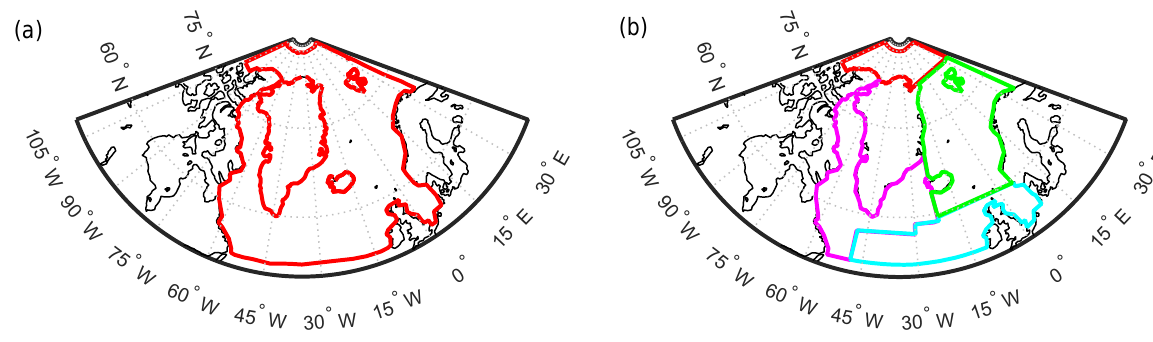
Figure A1. Parameterization of the ocean area around Greenland with one (a) and four (b)